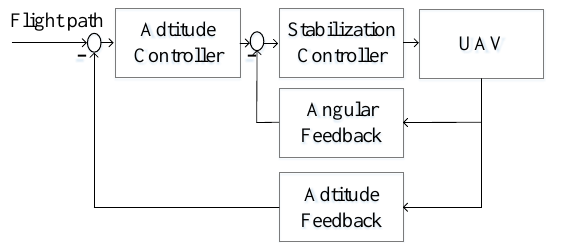
Figure 2. Inner loop of flight control system for a single UAV.